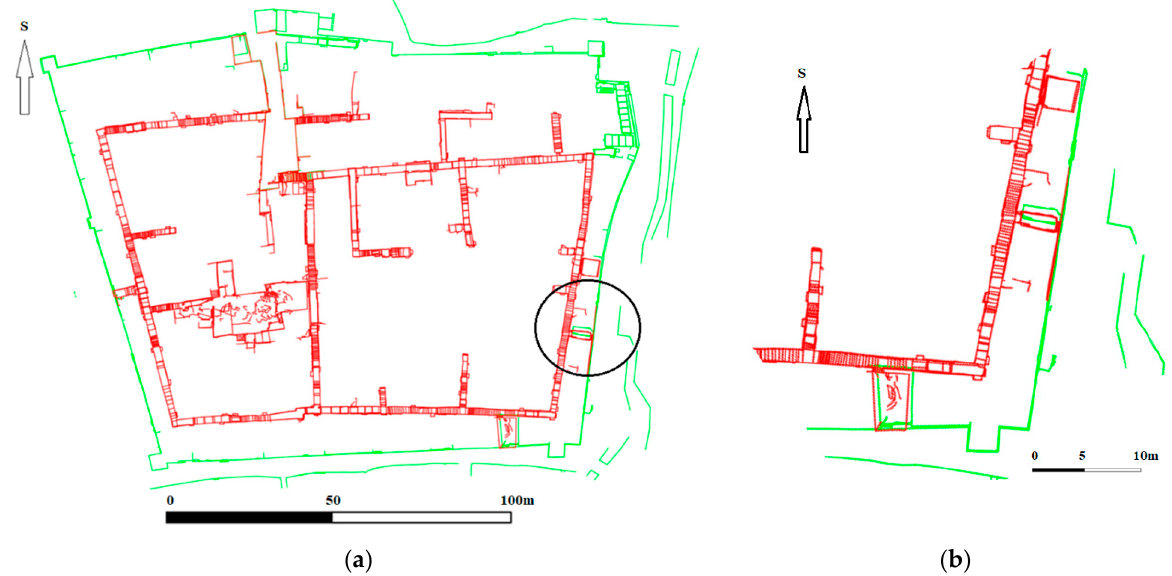
Figure 24. After joining both models from ZEB-REVO ( a ), discrepancies of about 1.2 m occurred in the lower right part of the model ( b ).